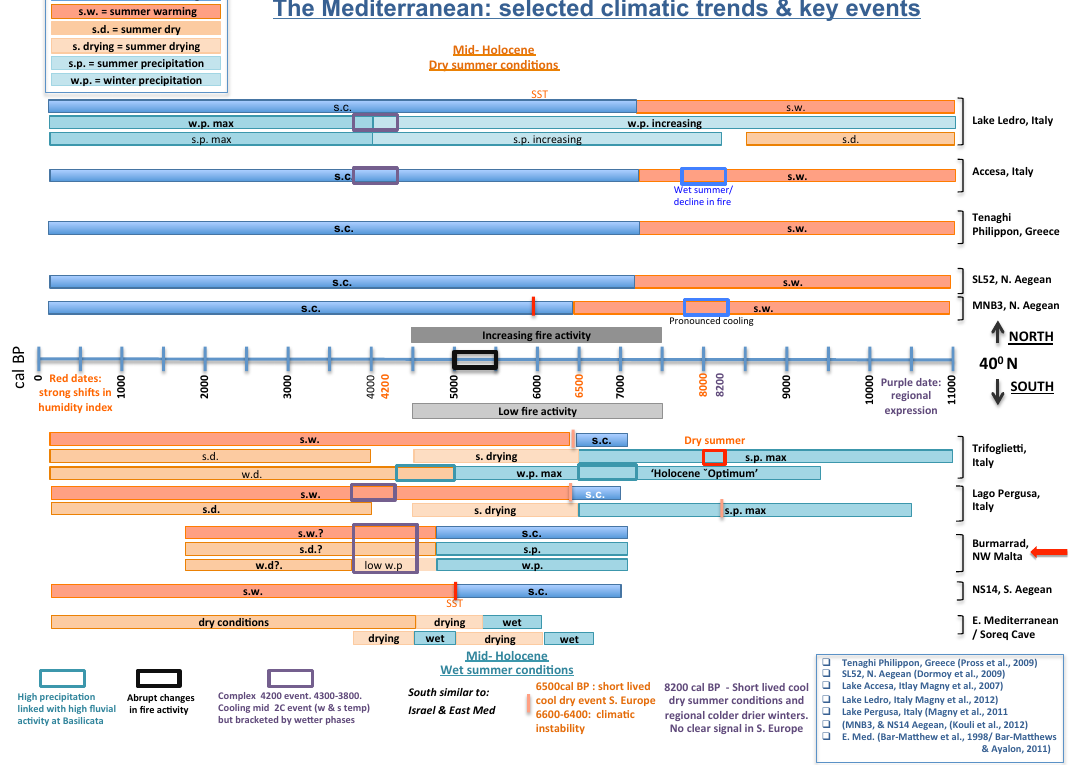
Figure 9. Synthesis of general trends and key events indicating Malta’s reconstructed climatic position (all data, except Burmarrad, from Peyron et al.,